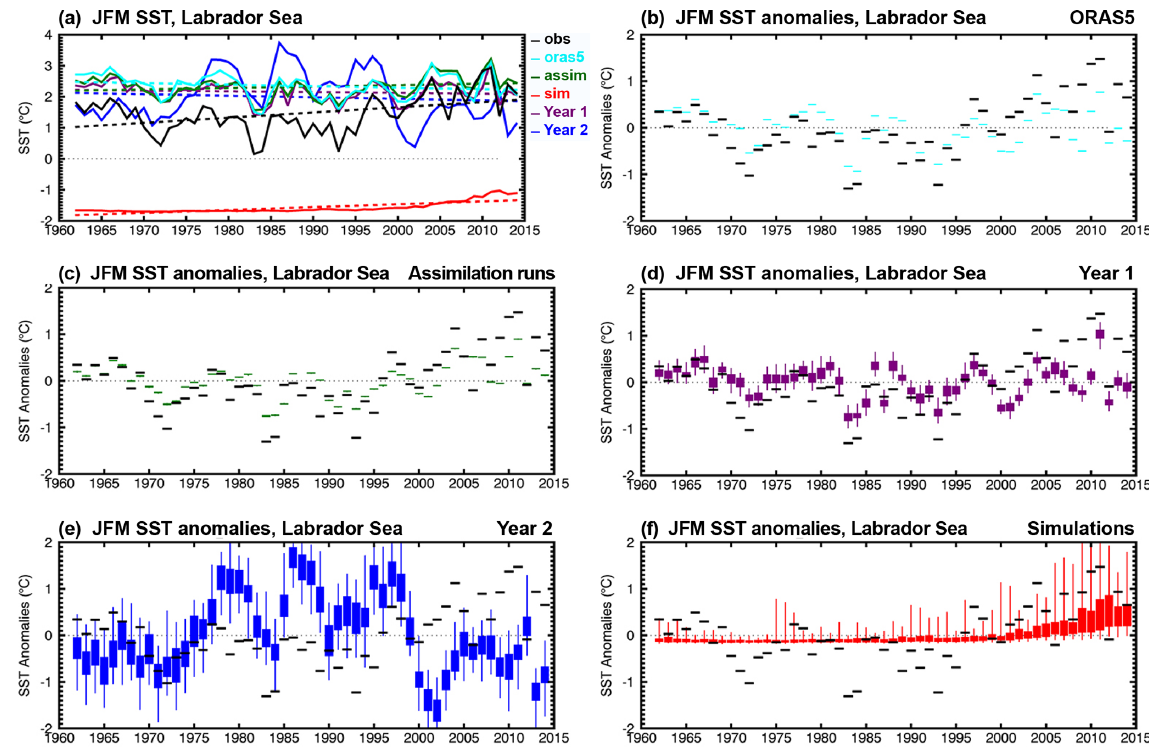
Figure 8. As in Fig. 7 for the Labrador Sea (55–65 ◦ N, 60–45 ◦ W).